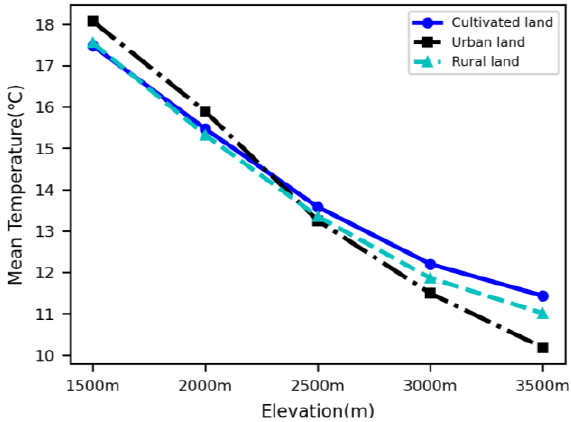
Figure 5. Variations of LST for urban, rural, and cultivated land with elevation.